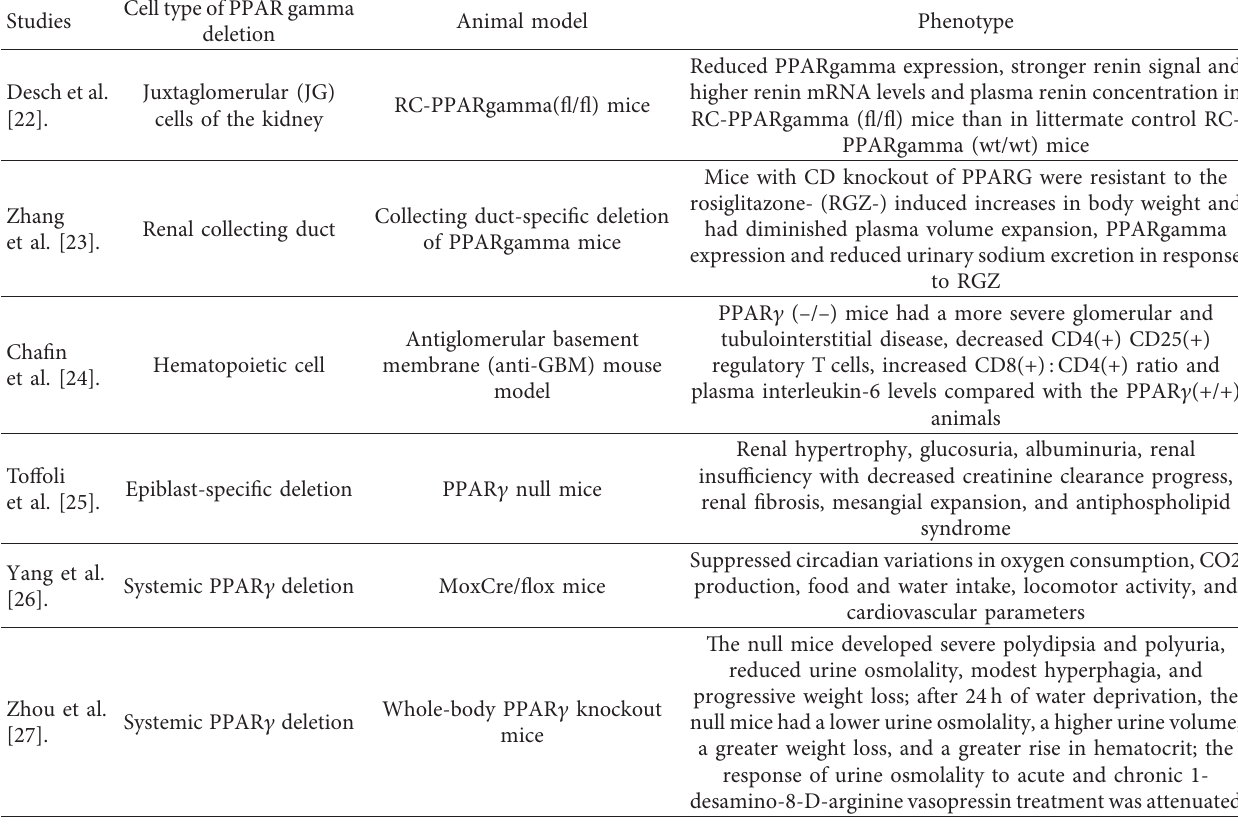
Table 1: Cell type of PPAR gamma deletion and the